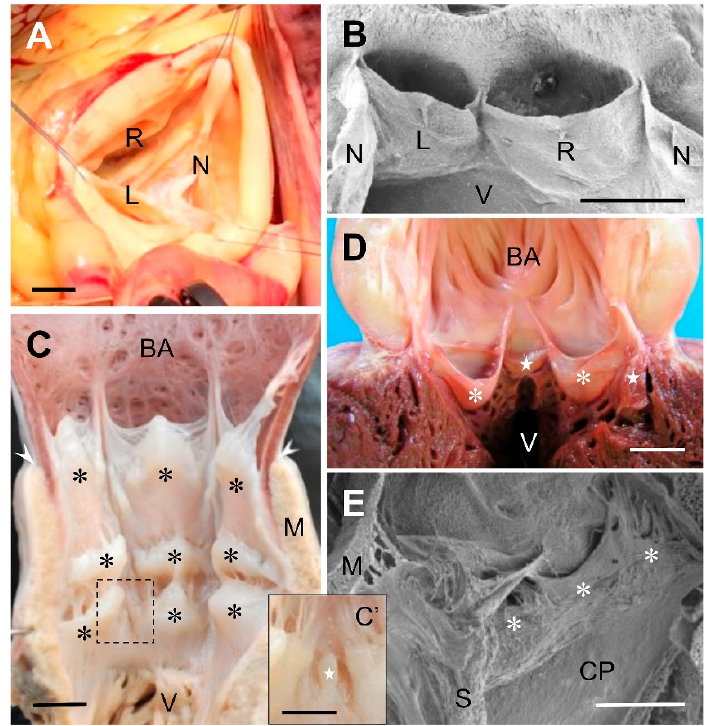
Figure 1. ( A ) Surgical view of a human normal, tricuspid, aortic valve. ( B ) Scanning electron micrograph of the aortic valve of a Syrian hamster ( Mesocricetus auratus ). The valve has been opened through the non-coronary sinus to expose the anterior aspect of the valve. ( C ) Ventral open-cut view of the cardiac outflow tract of the thresher shark, Alopias vulpinus . The conus arteriosus is furnished with three transverse rows of valves (asteriks), distal, intermediate, and proximal. The rows have three valves each, of similar size. The valves of the distal row are bigger. In the intermediate and proximal rows there are additional valves very reduced in size, (( C’ ), inset). The arrowheads indicate the anterior limit of the conus myocardium. ( D ) Ventral open-cut view of the cardiac outflow tract of the Atlantic bluefin tuna, Thunnus thynnus . A single row of four valves, two major (asterisks) and two minor (stars), similar in shape to human valves, are located in the conus, at the base of the bulbus arteriosus (BA). ( E ) Scanning electron micrograph of the distal region of the cardiac outflow tract of the African clawed frog, Xenopus laevis . The open-cut view shows a set of pocket-like valves (asterisks) located at the distal end of the cavum pulmo-cutaneum (CP). L, left coronary leaflet; M, myocardium; N, non-coronary (dorsal, posterior) leaflet; R, right coronary leaflet; S, spiral valve; V, ventricle. Scale bars: ( A ): 1 cm; ( B – E ): 0.5 mm; ( C’ ): 0.25 mm.